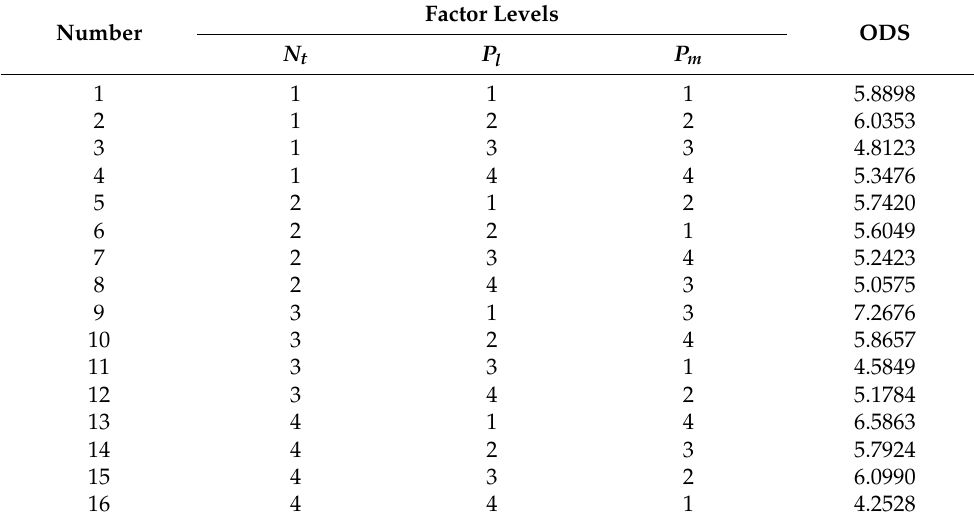
Table 3. L 16 Taguchi experiment for the